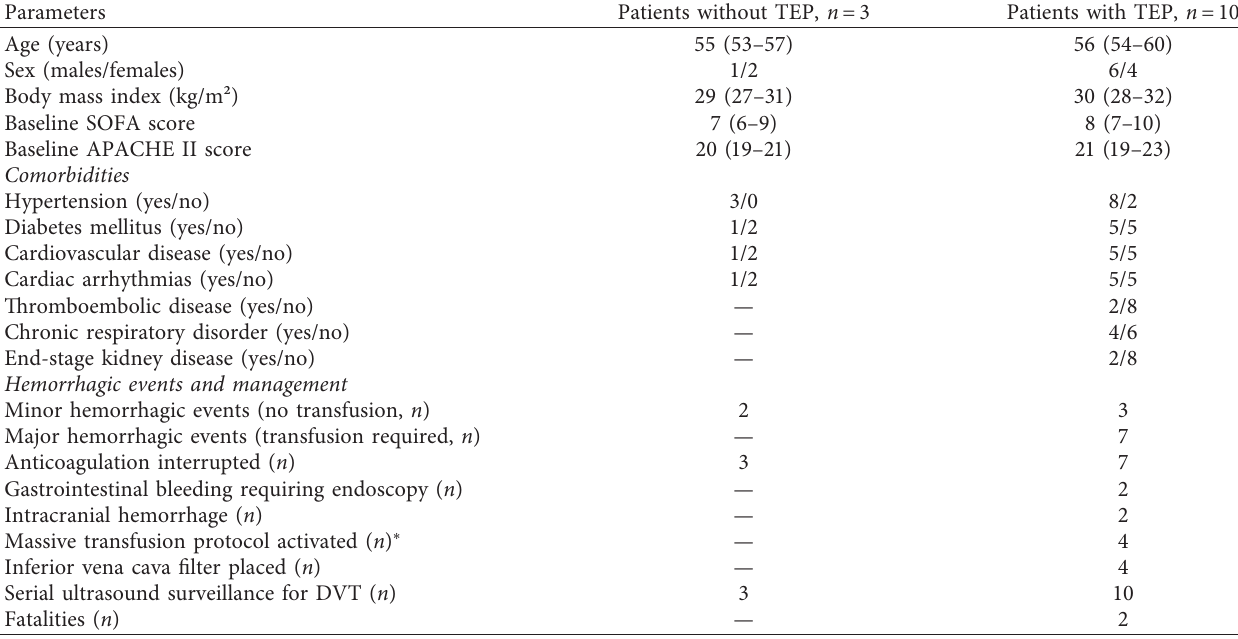
Table 2: Characteristics of thirteen critically ill COVID-19 patients who developed hemorrhagic